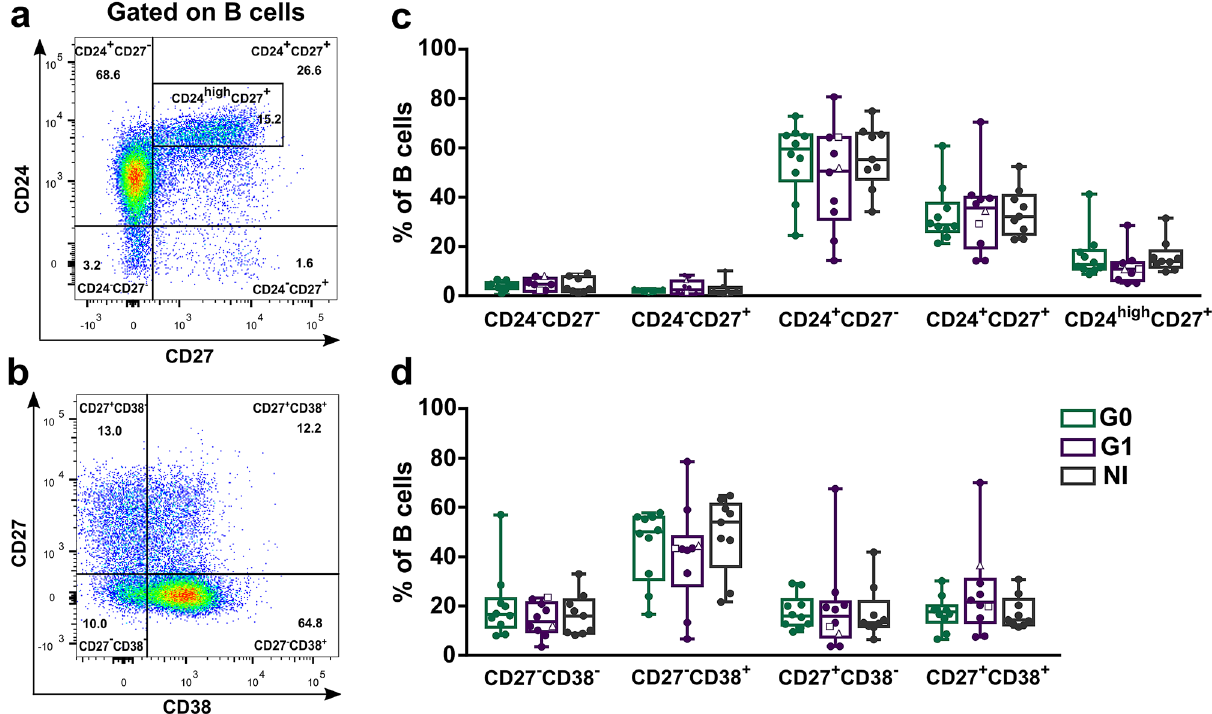
Figure 2. Frequency of B cell subsets based on CD24 and CD27 or CD27 and CD38 markers expression in peripheral blood from CCD patients and non-infected donors. ( a , b ) Representative dot plots from a non- infected donor showing the gating strategy used to determine the subsets within total B cells according to the combined expression of CD24 and CD27 or CD27 and CD38. ( c , d ) Frequency of B cell subsets in CCD patients (G0, G1) and non-infected donors (NI). Each dot represents data from one subject; inside G1 group, solid circles correspond to K1 patients, hollow triangle to K2 patient and hollow square to K3 patient. Boxes and whiskers show median value and interquartile